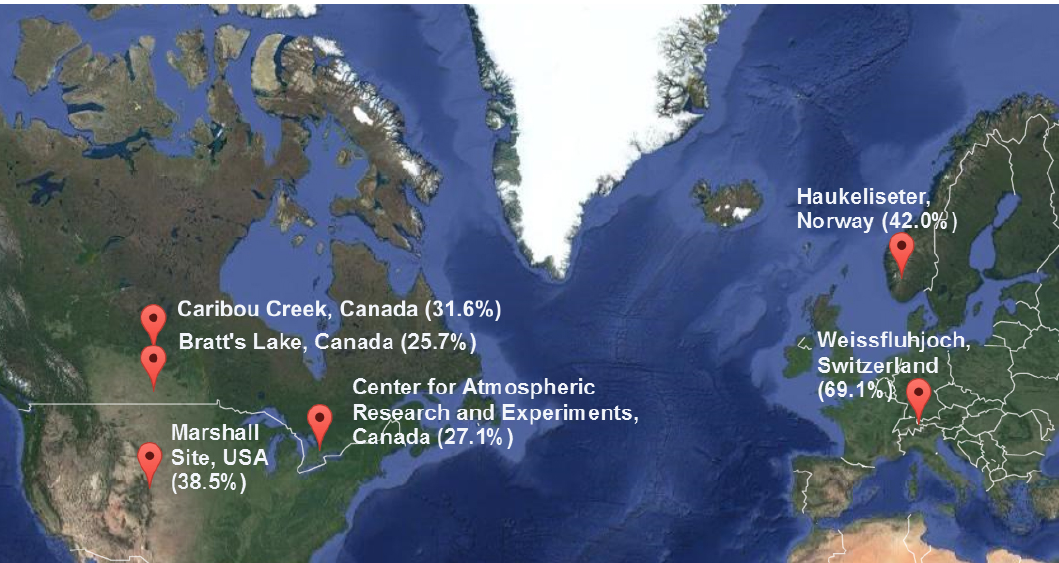
Figure 1. Map of WMO-SPICE test sites with weighing gauges considered in this study. In addition, the percent of total precipitation that occurred as solid precipitation is shown in brackets. For the Caribou Creek, Bratt’s Lake, Center for Atmospheric Research and Experiments (CARE), and Marshall sites the closest sites with 30 year climate normals (1981–2010) were used; at Haukeliseter and at Weissfluhjoch local observations were used from 1994 to 2017 and 1981 to 2010,